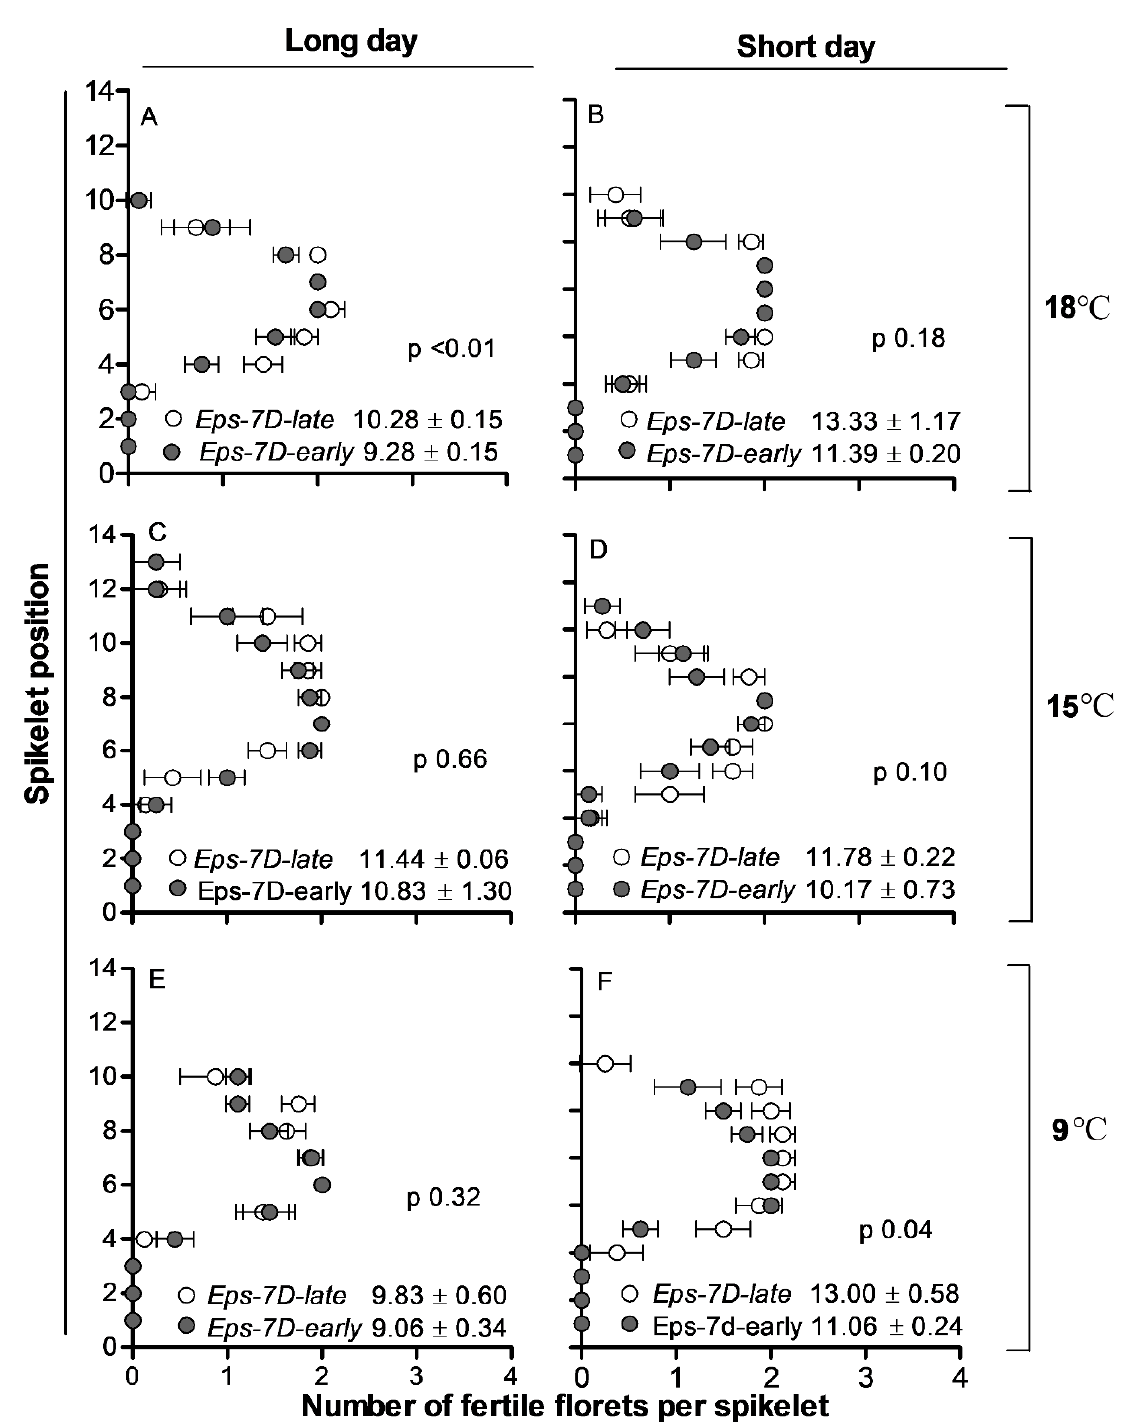
Figure 5. Number of fertile florets at anthesis per spikelet from basal to terminal spikelet for Eps-7D - late (open circles) and - early (closed circles) NILs under long ( A , C , E ) and shot days ( B , D , F ) at 18 ( A , B ), 15 ( C , D ) and 9 °C ( E , F ). Inside each panel are the fertile florets per spike with standard error of means and p value.